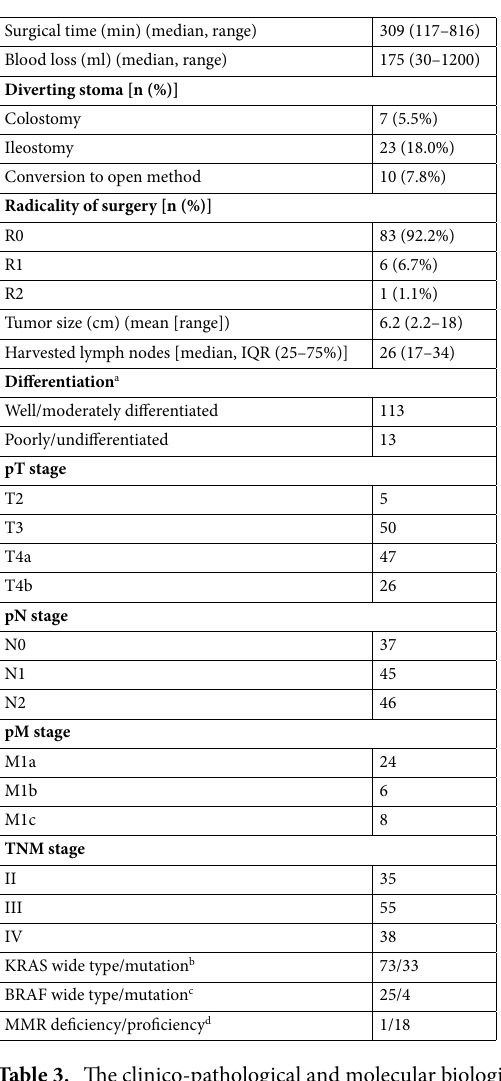
Table 3. The clinico-pathological and molecular biologic features of patients. a The grade of differentiation was not reported by pathologists in 2 patients because of status post concomitant chemoradiation therapy. b Twenty-two patient’s KRAS status were not available. c Only 29 patients’ data were available. d Only 19 patients’ data were available.